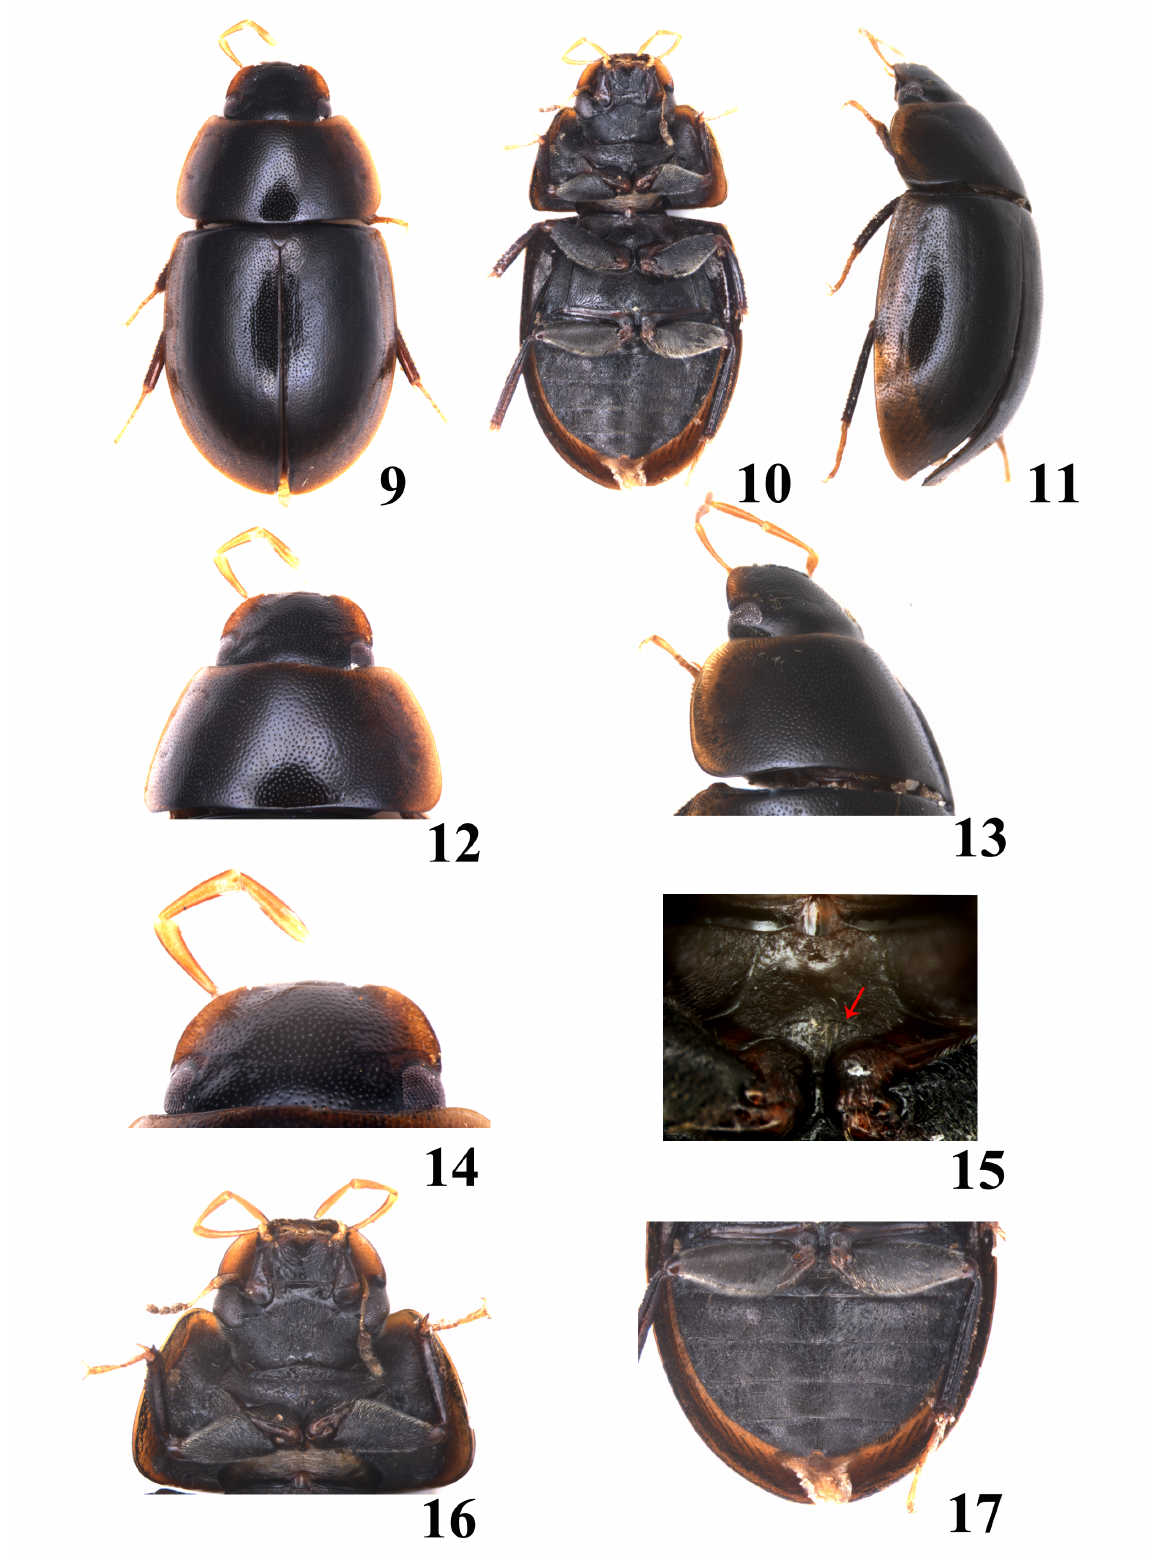
Figs 9–17. Helochares fuliginosus d’Orchymont, 1932. 9–11 . Habitus. 9. Dorsal. 10. Ventral. 11. Lateral. 12–13 . Head and pronotum. 12. Dorsal. 13. Dorsolateral. 14 . Head, dorsal. 15 . Mesoventrite. 16 . Head and prosternum. 17 .